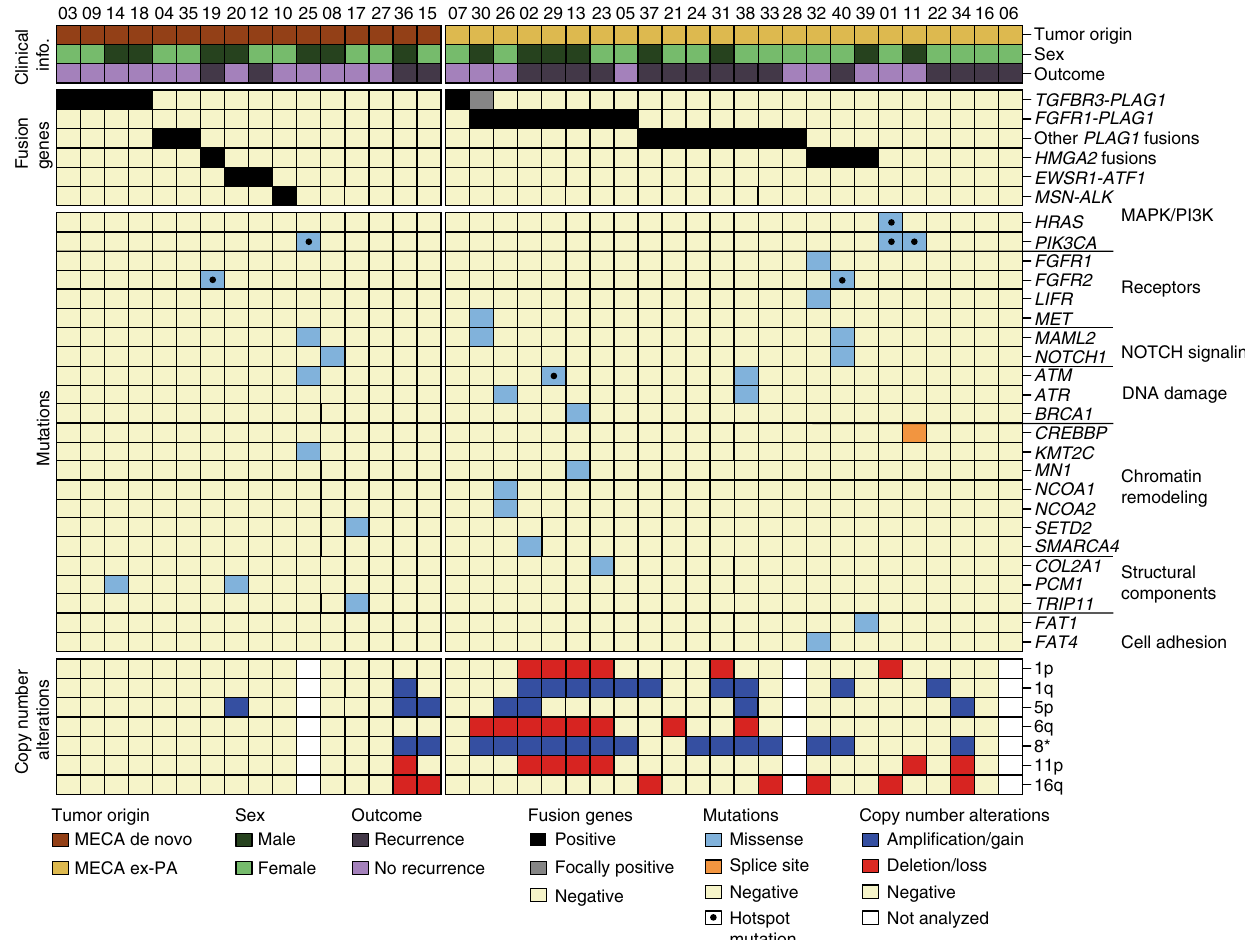
Fig. 1 Genetic landscape of MECA. Clinical information, fusion genes, mutations, and arm-level copy number alterations in 40 cases of MECA. Mutations of genes listed in cancer census that are reported in more than one case in the COSMIC database are shown. Hotspot mutations are those reported in